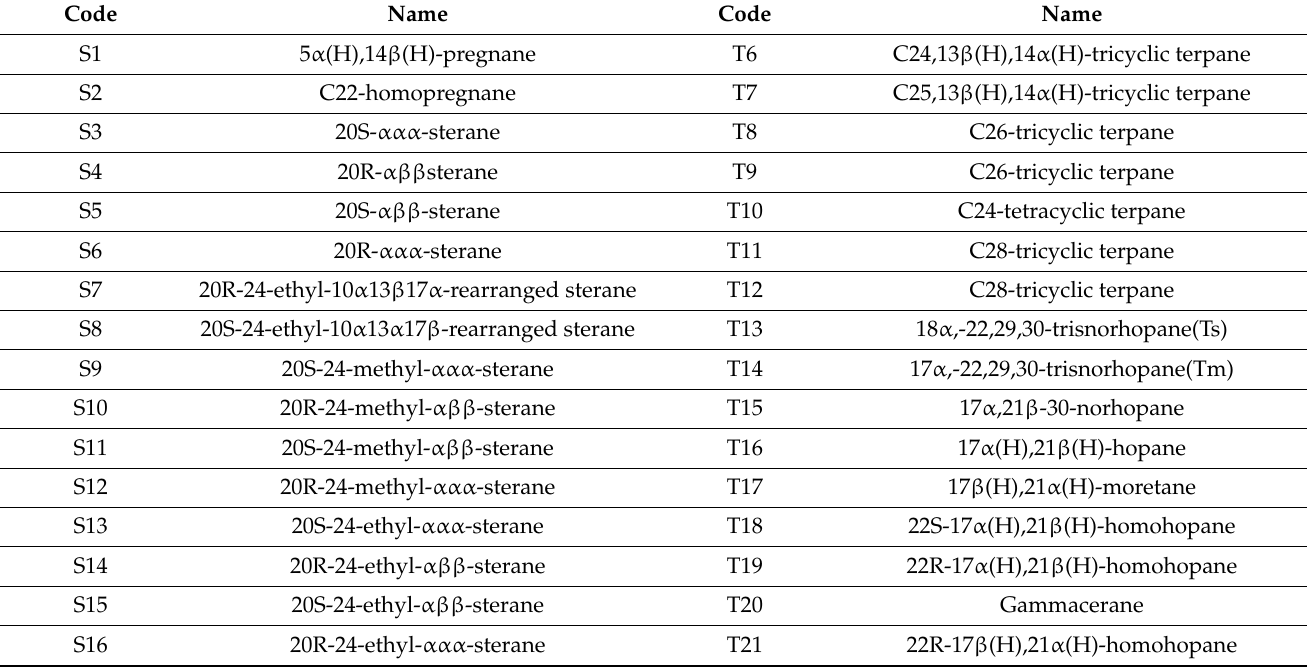
Table 2. The definition of the biomarker